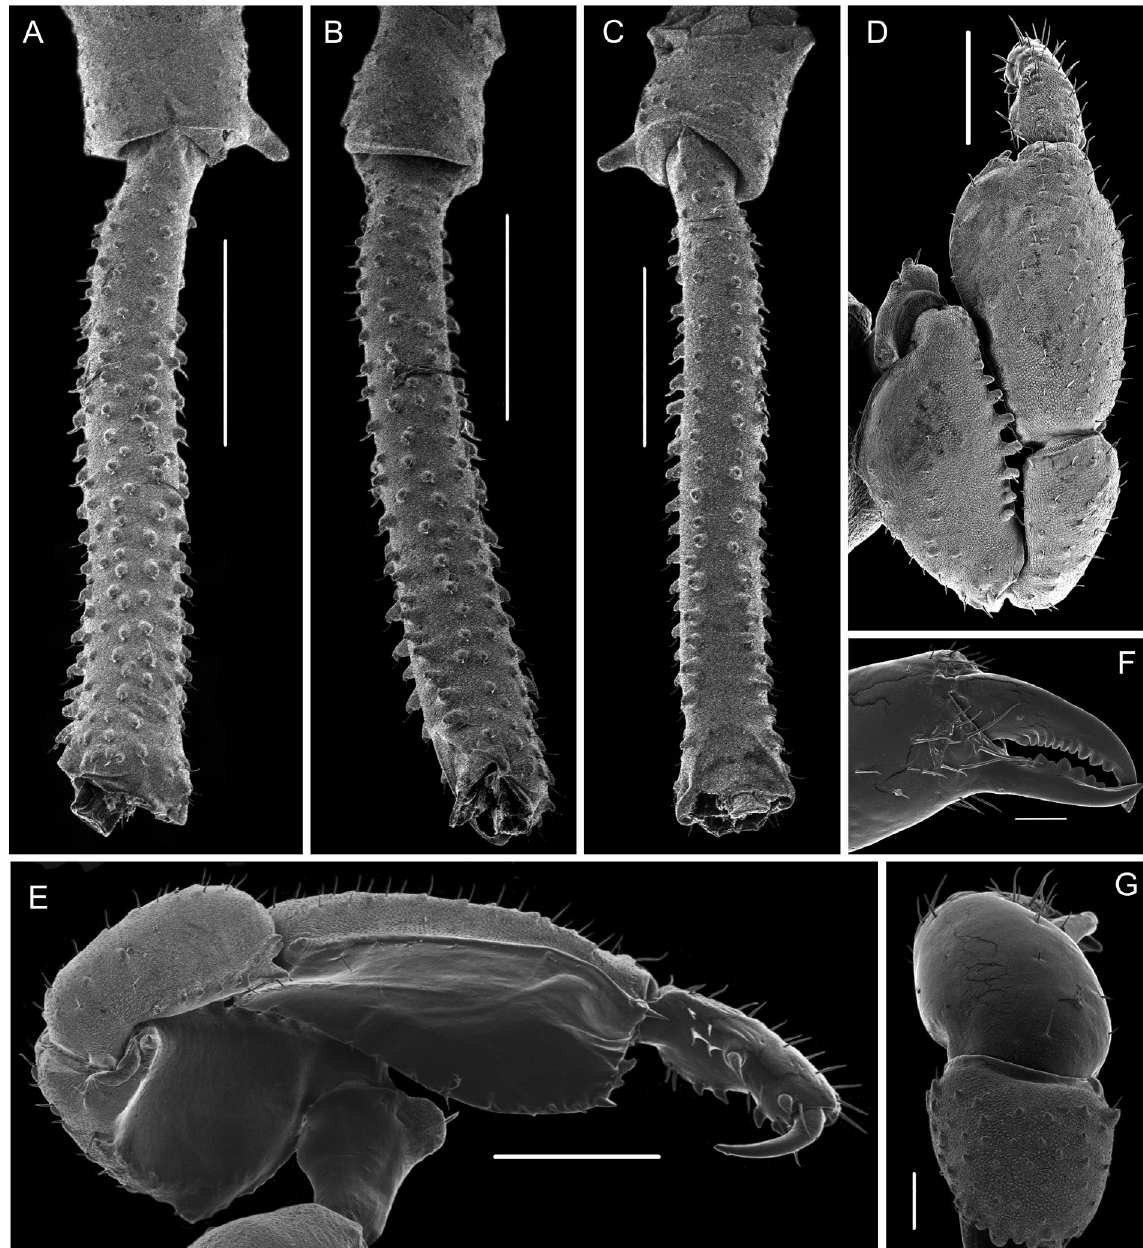
Fig. 29. Eulibitia scalaris (Sørensen in Henriksen, 1932) comb. nov., ♂ (ICN-AO 1208). A . Trochanter and femur of leg IV, dorsal view. B . Same, prolateral view. C . Same, ventral view. D . Left pedipalpus, ectal view. E . Same, mesal view. F . Fingers of the hand of left chelicera, dorsal view. G . Left chelicera, dorsal view. Scale bars: A–C = 1 mm; D– E = 500 µm; F–G = 200